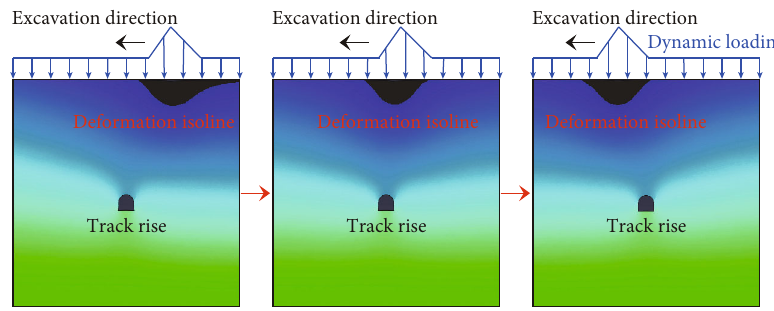
Figure 6: Regional characteristics of large vertical deformation.